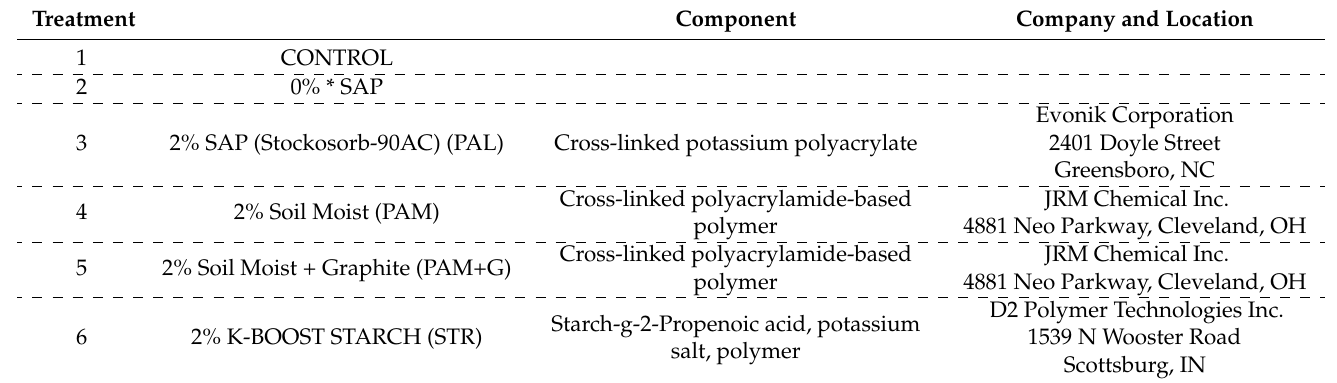
Table 1. Hydrophilic commercial polymers used in this